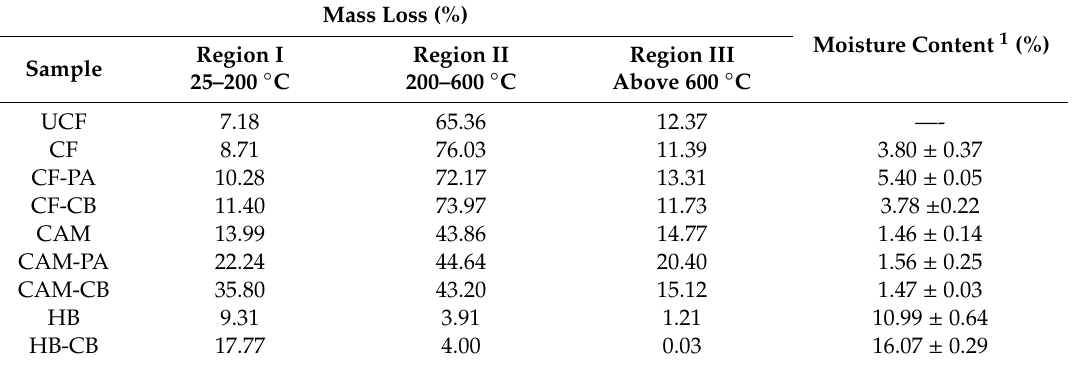
Table 1. Mass loss data (%) and moisture content (%) by TGA. Untreated coconut fiber (CF),